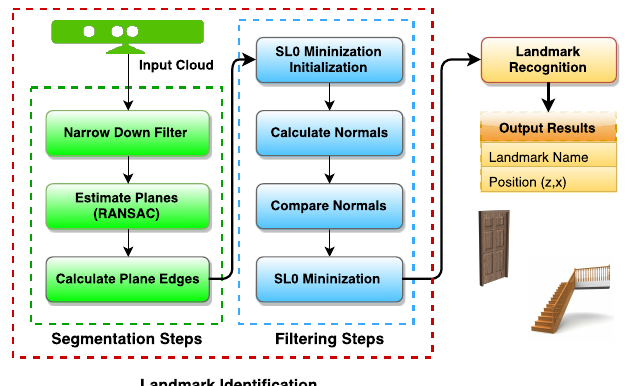
Figure 1. Natural landmark identification stage.